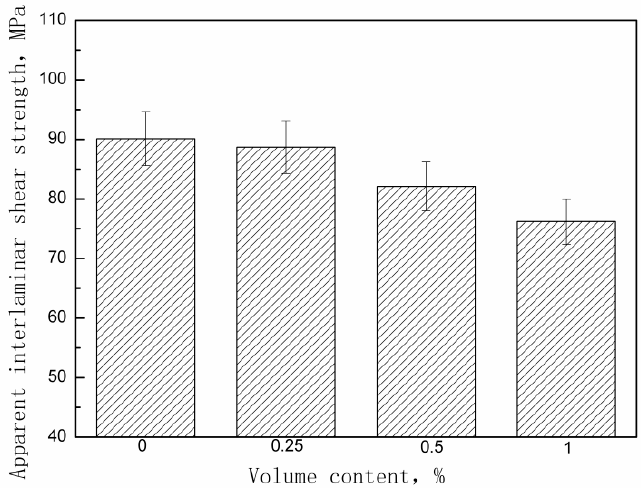
Figure 4. Effect of metal pin content on apparent interlaminar shear strength of z-pinned Cf/Al composites using stainless steel pins with diameters of 0.3 mm. Table 3 . Apparent interlaminar shear strength of unpinned Cf/Al composites and z-pinned Cf/Al composites using stainless steel pins with diameters of 0.3 mm measured by short-beam shear test.